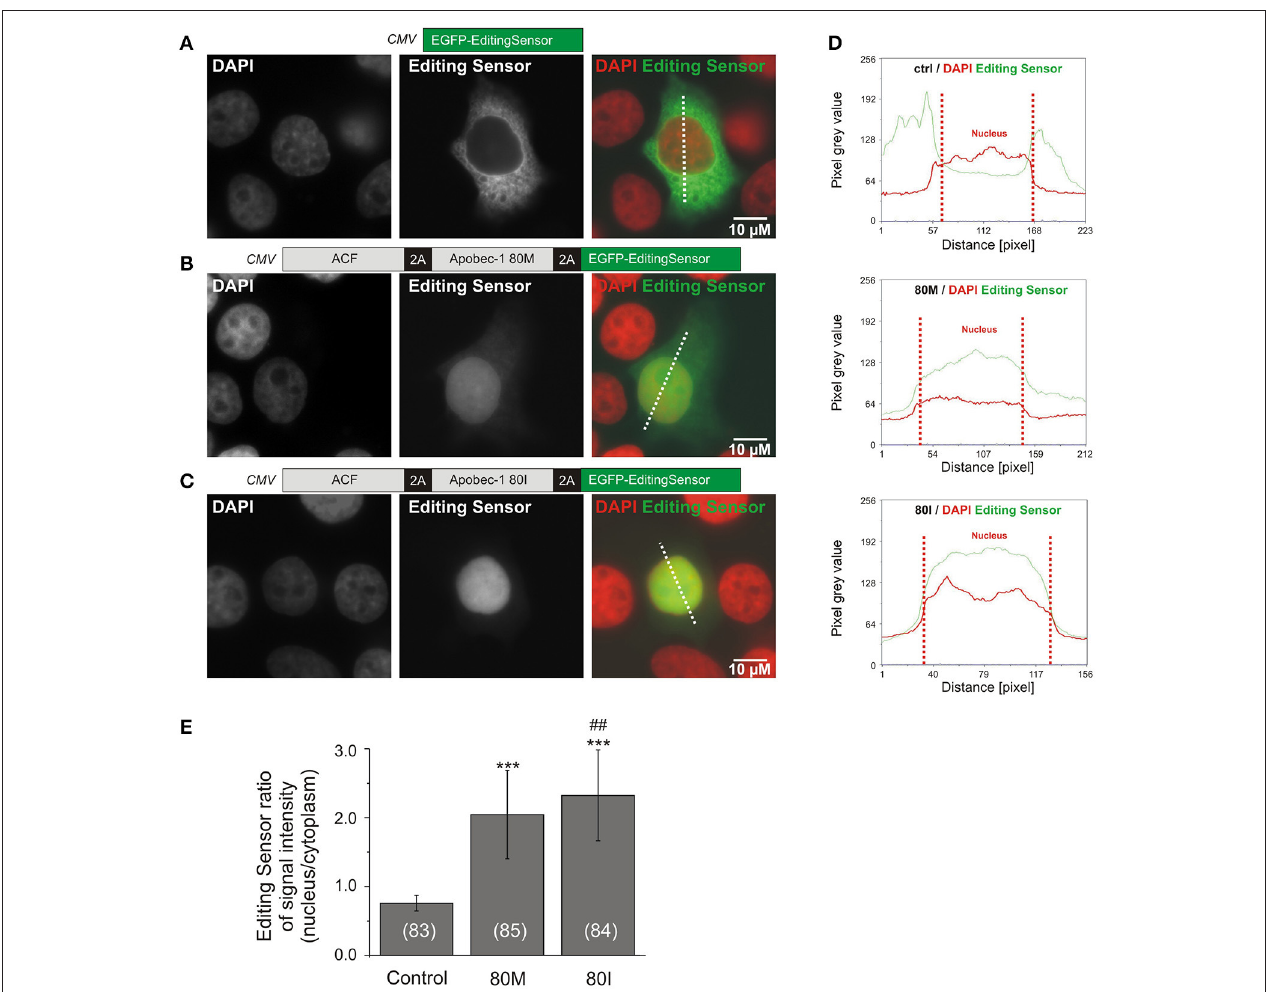
FIGURE 3 | The C-to-U RNA editing deficient HEPG2 liver carcinoma cell line was used to evaluate the functionality of the RNA editing sensor. (A–C) Representative images of HEPG2 cells transfected with the constructs shown in Figure 2B . Images show fluorescence corresponding to DAPI (left panels), sensor signals (middle panels), and merged signals (right panels) without ( A , control, editing sensor alone) or with Apobec-1 80M ( B , 80M) or Apobec-1 80I ( C , 80I) co-expression. Dotted lines show examples of the placement of line-scans shown in (D) . (D) Line scans of pixel intensities of the editing sensor (green) and DAPI (red) through cytosol and nucleus in the three different conditions are shown. Dotted red vertical lines delineate the nuclear region in each case (“Nucleus”). (E) Quantification of the fluorescence ratios between nucleus and cytosol in line-scanned specimen. All data are given as mean ± SD. Asterisks mark significant differences between editing sensor alone and with 80M or 80I. The “##” symbol indicates a significant difference ( P = 0.006) between 80M and 80I while *** mark significant differences between control and 80M or 80I ( P < 0.001), as assessed using Mann-Whitney test. The number of analyzed cells is indicated in